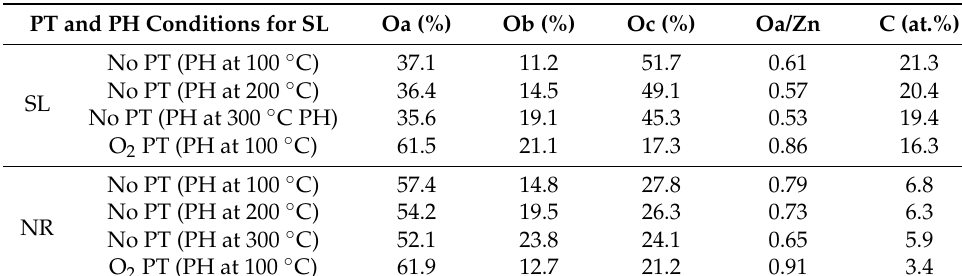
Table 3. Percentage values of the XPS O1s satellite peaks from the as-coated (PH at 100, 200, and 300 ◦ C) and O 2 -plasma-treated (PH at 100 ◦ C) SLs and NRs grown on each SL crystal. Each percentage